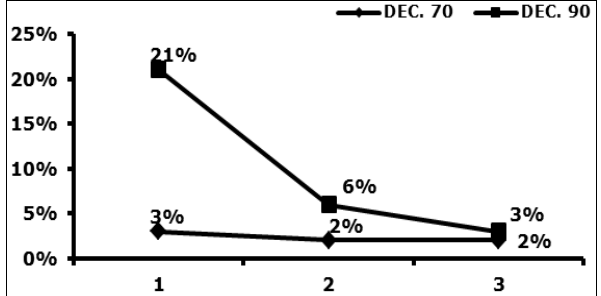
Figure 9- Distribution of use of generic você (“you”, “people”), in the 70's and 90's, by age group (Callou & Avelar,